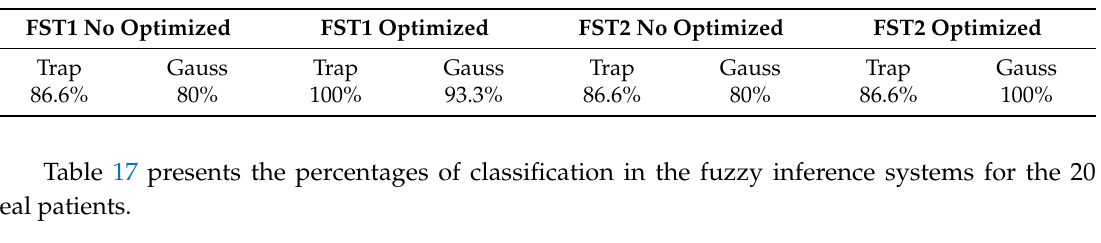
Table 17. Classification with type-1 and interval type-2 fuzzy systems with real patients. FST1 No